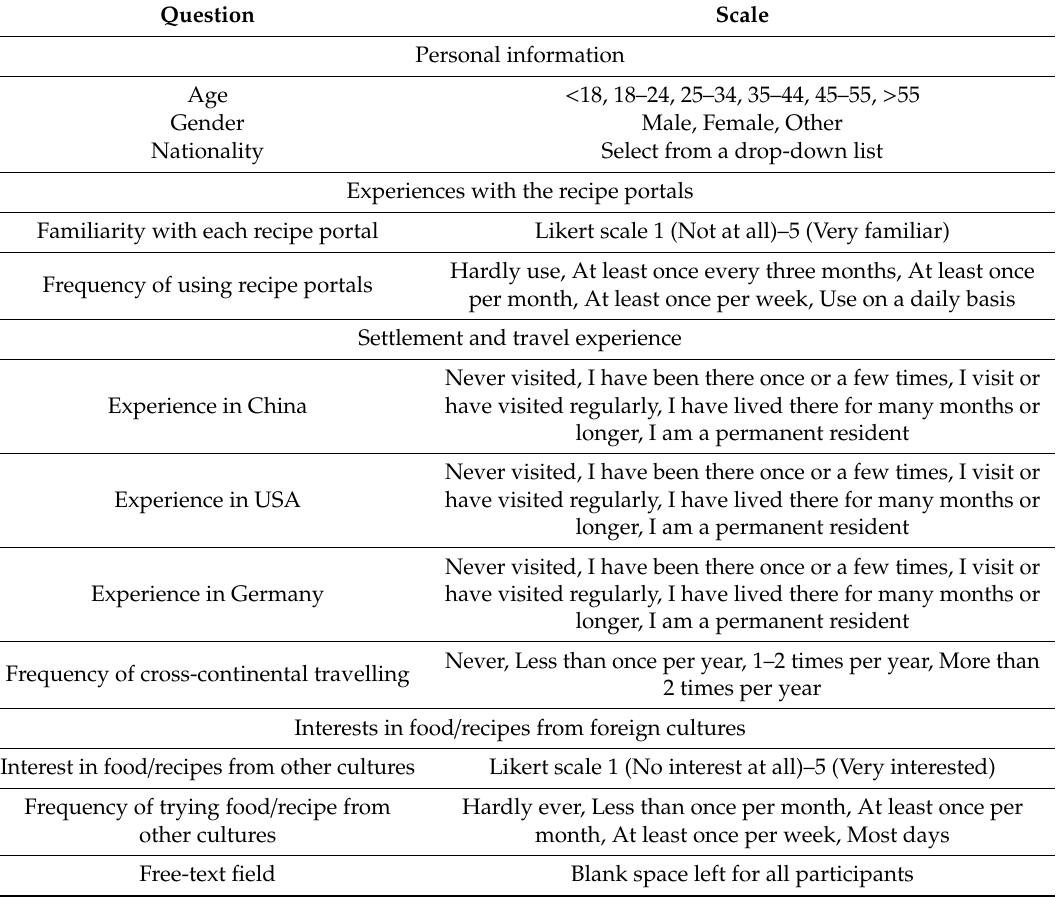
Table 1. Survey questions for the